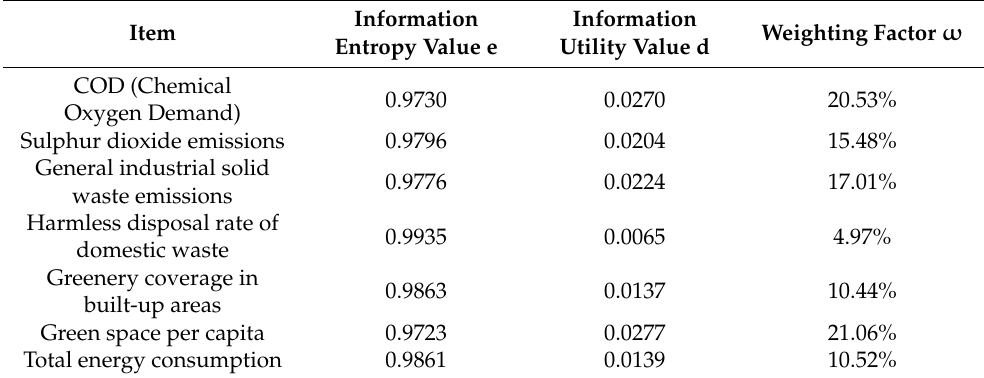
Table 4. Summary of the results of the entropy method for calculating